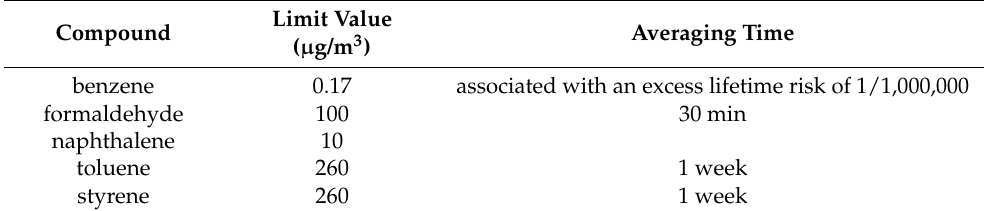
Table 2. Guideline values for individual substances [1,30]. Limit Value Compound